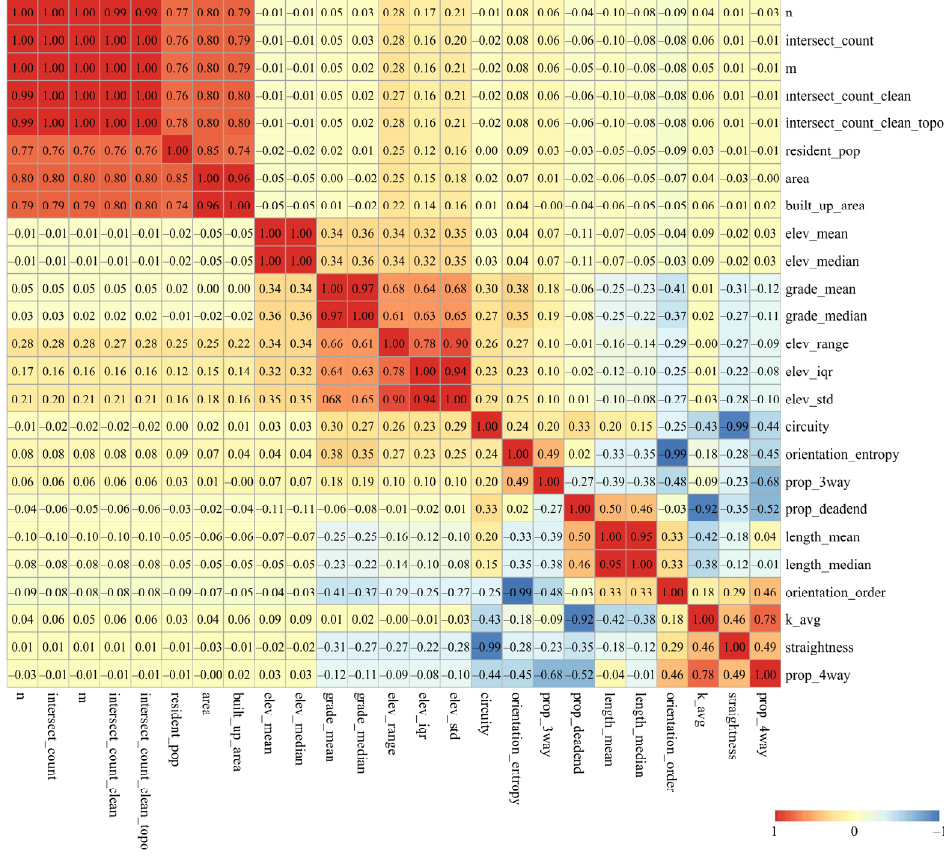
Figure 1. Correlations among all pairs of 25 indicators. The p -value is smaller than 0.05, while the correlation is larger than 0.02 or smaller than −